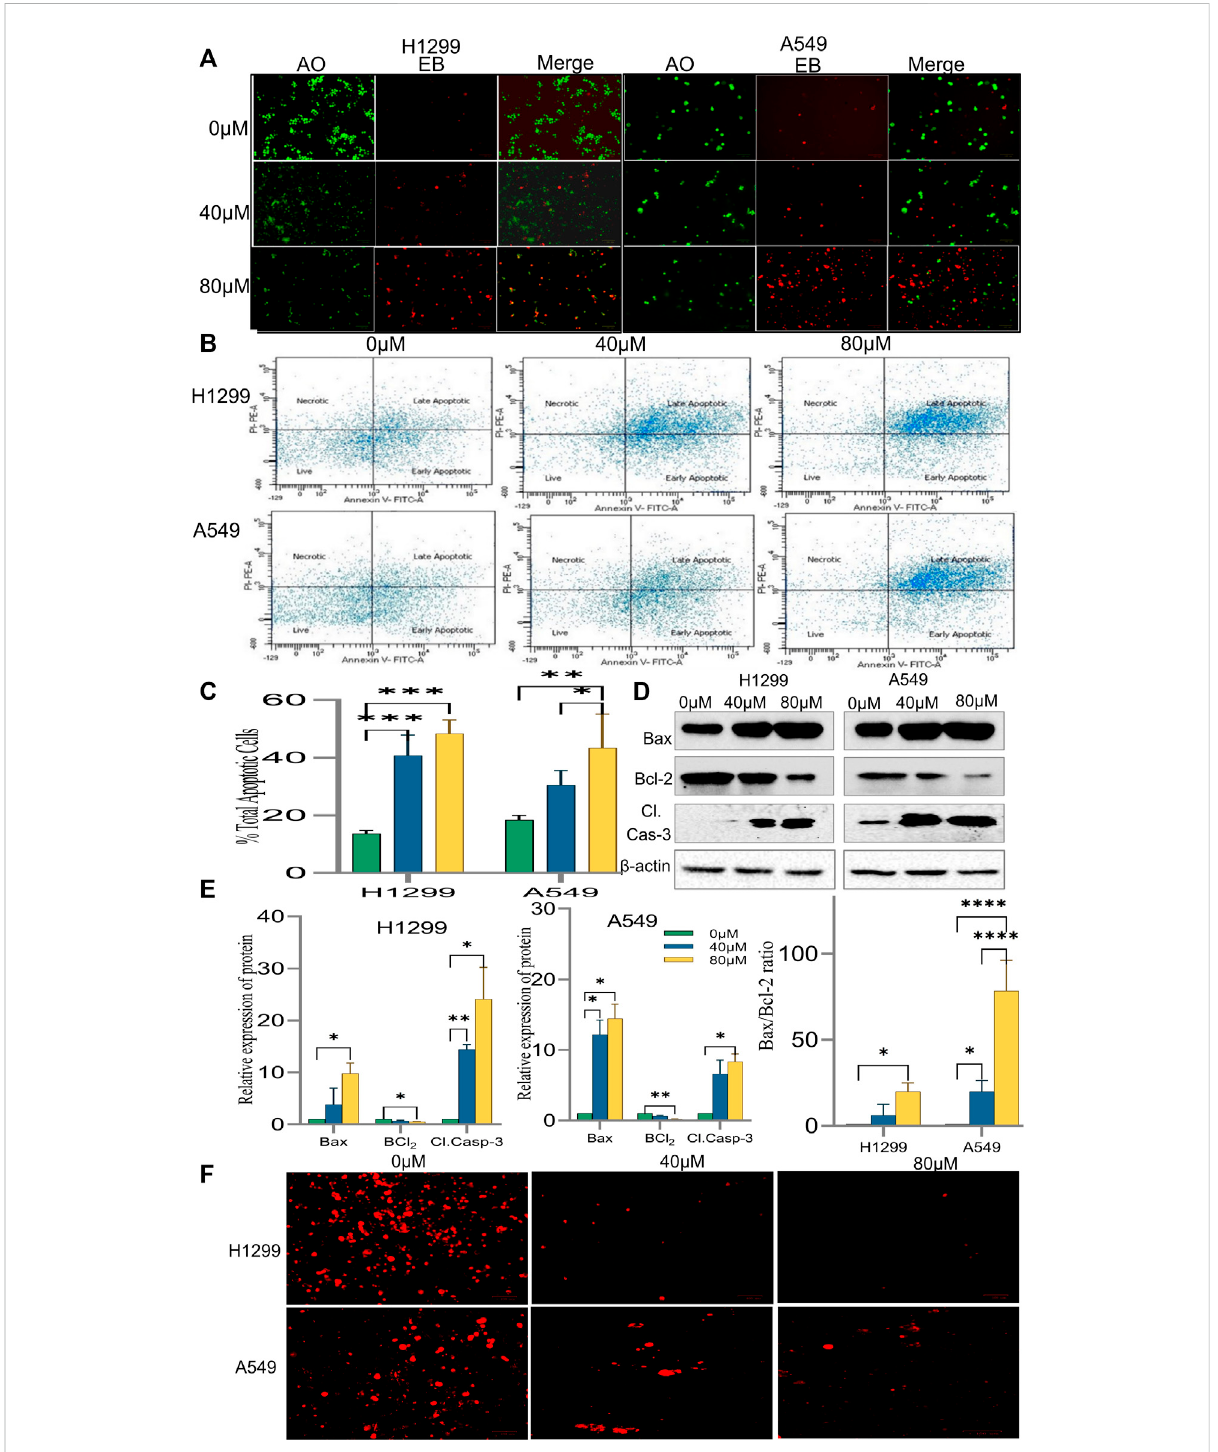
FIGURE 6 Induction of apoptosis by 18 α -GA in H1299 and A549 cells. (A) Images of AO/EB staining by fl uorescence microscopy; Green fl uorescence represents healthy cells, Red cells represents cells undergoing late apoptotic stage. (B) Fluorescent images showing cell distribution in different stages of apoptosis detected by FACS. (C) %total apoptotic cells found after treatmentwith 18- α GA; ( n = 3, mean ± SD), statistical analysis was done by 2-way ANOVA followed by Sidak ’ s Post-hoc multiple comparison test. * p < 0.05, ** p < 0.01, *** p < 0.001, **** p < 0.0001. (D) Western blots showing expressions of apoptotic-related proteins. (E) Graphs representing protein expression levels after normalisation with beta-actin, statistical analysis was done by 2-way ANOVA followed by Tukey ’ s Post-hoc multiple comparison test, * p < 0.05, ** p < 0.01, *** p < 0.001, **** p < 0.0001. Graph representing calculated Bax/Bcl-2 ratio, Sidak ’ s multiple comparison test was used. (F) Fluorescent images show TMRM staining for mitochondrial membrane